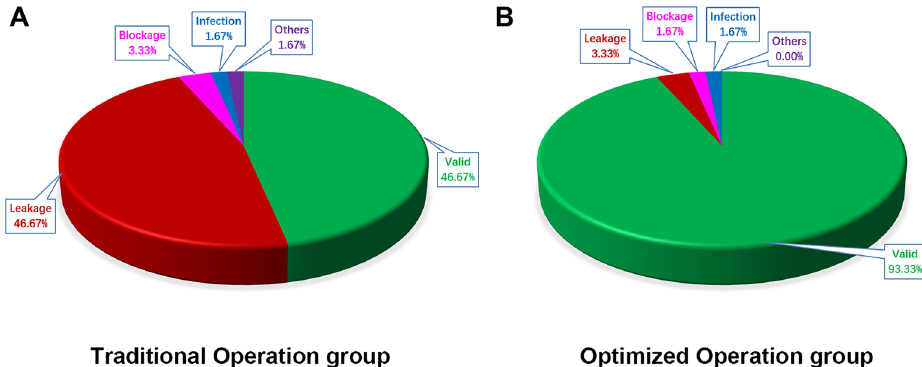
Figure 3. The effect of jugular vein catheterization for rats in two group. The statistical results showed the success rate of operation in the Traditional Operation group (TO group) was 46.67% and that in the Optimized Operation group (OO group) was 93.33%.